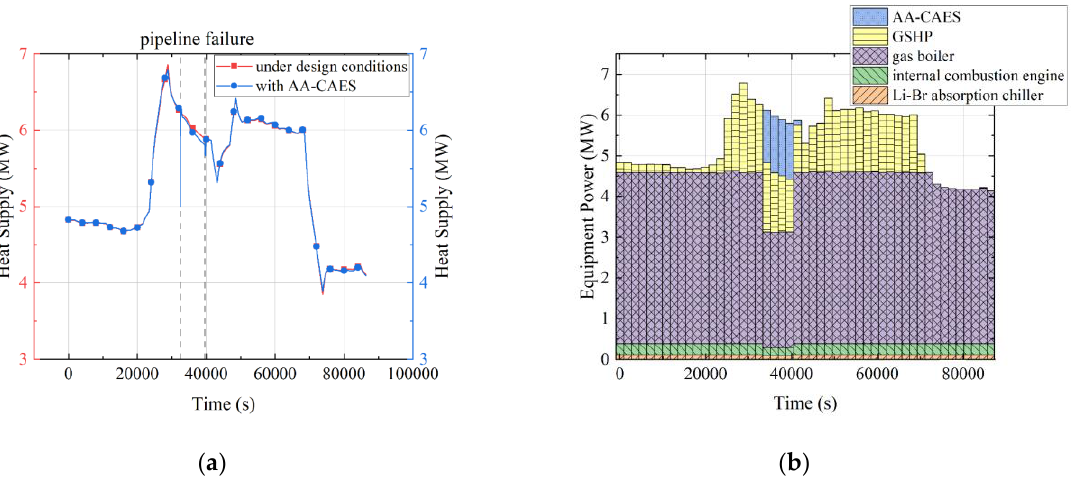
Figure 12. Dynamic response of IES with AA-CAES method. ( a ) heat supply; ( b ) equipment power.